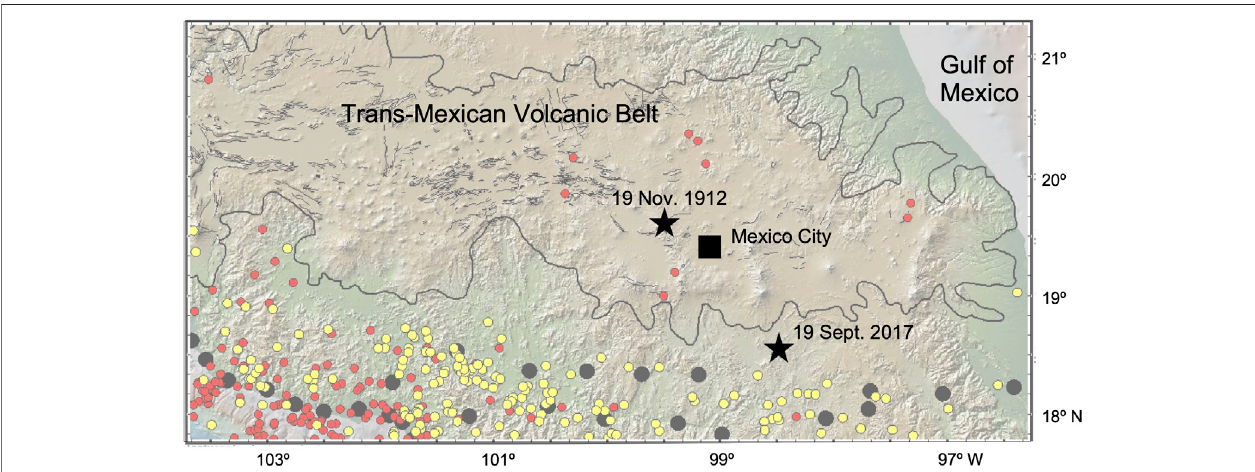
FIGURE 4 | Location of the 19 September 2017 ( Mw 7.1) and 19 November 1912 ( Mw 6.9) earthquakes relative to SASMEX accelerographs (solid black circles) and Mexico City (black square) from the same catalog and period as Figure 1 . The yellow dots represent in-slab earthquakes and red dots are events shallower than 30 km.TheblacksolidlinerepresentstheboundaryoftheTrans-MexicanVolcanicBelt,andtheshortblacklinesinitaremappedfaults.The1912earthquaketookplace in one of these crustal faults.